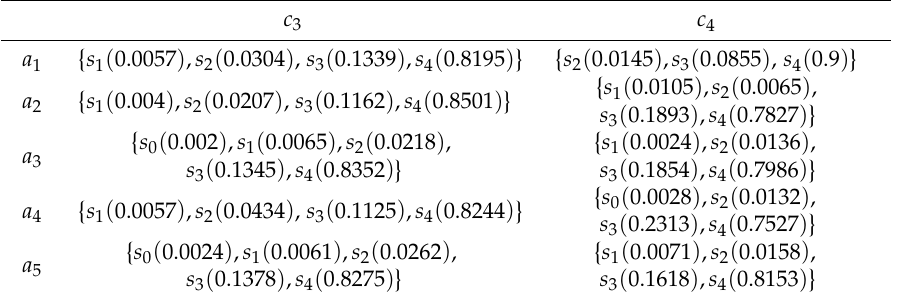
Table 2. Evaluation values for each hotel under criteria c 3 and c 4 .